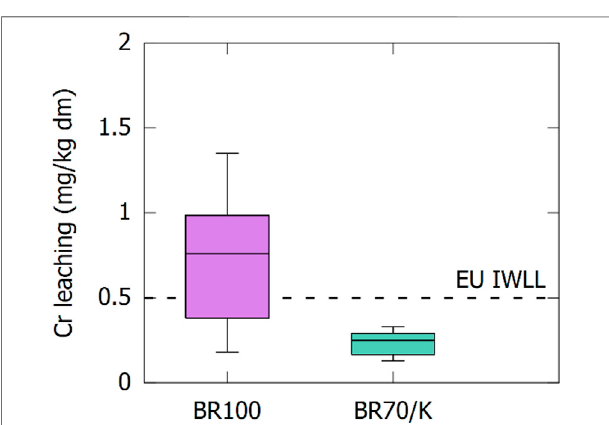
FIGURE 10 | Compressive strength of mortars with 30 wt% of (co-) calcined BR as SCM relative to a reference sample of the CEM I. The dashed lines indicate the relative strengths of a mortar with co-calcined quartz Q70/K as a basis of comparison for the BR70/K samples.